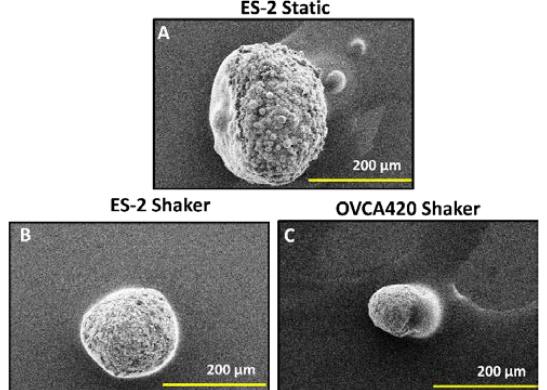
Figure 6. Three-dimensional (3D) nature of shaker-produced spheroids. ( A ) Reference Scanning Electron Microscopy (SEM) image of an ES-2 spheroid generated in 96 RB WP to show 3D structure. ( B , C ) SEM images of shaker-produced ES-2—( B ) and OVCA420 spheroids ( C ) The smooth mass seen on the side of spheroids is mounting media from the coverslip. Scale Bar: 200 µm.